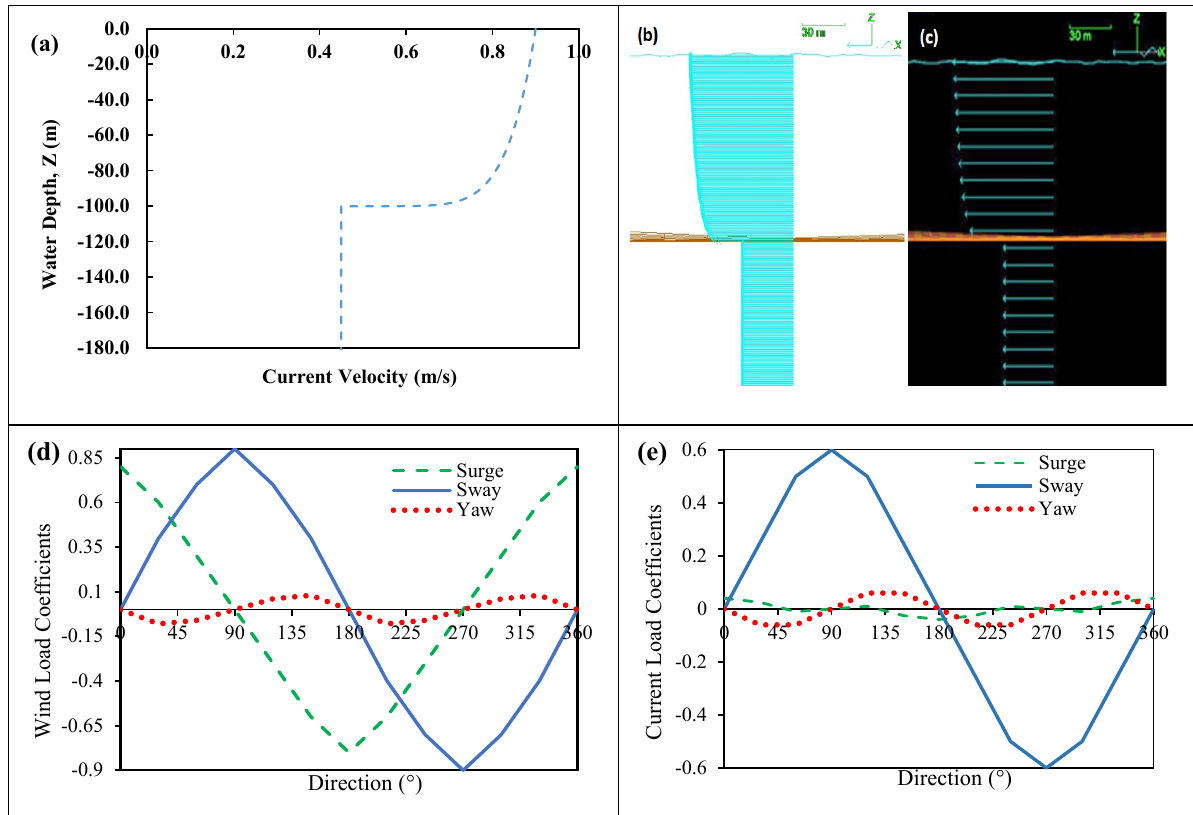
Figure 15. Profiles showing details of ( a ) the vertical profile for Surface Current and Seabed Current at seabed origin, and ( b ) the Orcaflex 3D current profile for both currents, ( c ) the Orcaflex 2D current profile for both currents, ( d ) Load Coefficient for Wind on the CALM buoy, and ( e ) Load Coefficient for Current on the CALM buoy.